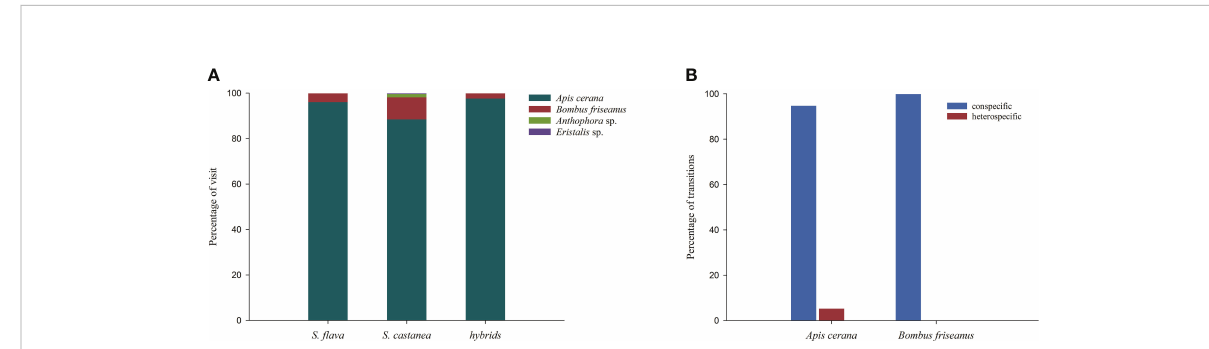
FIGURE 4 Proportion of fl ower visitors to S . fl ava , S . castanea and hybrid plants in a natural setting (A) , and transition percentages of pollinators in the manual plots (B) . Transition types were categorized as: conspeci fi c ( S. fl ava – S. fl ava , or S . castanea – S . castanea ) and heterospeci fi c ( S . fl ava – S . castanea , or S . castanea – S . fl ava